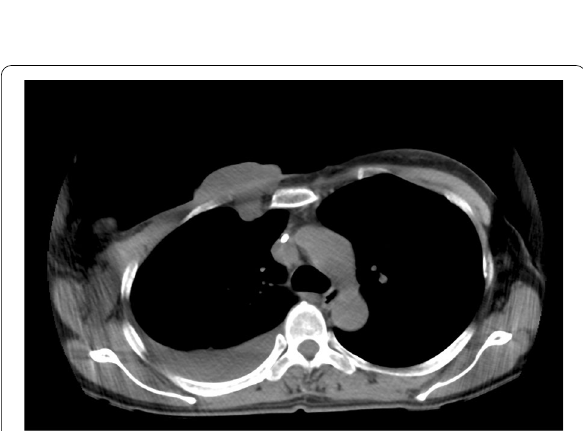
Fig. 6 Computed tomography showed a mild reduction in chest wall tumor and pleural dissemination after one cycle of AI therapy